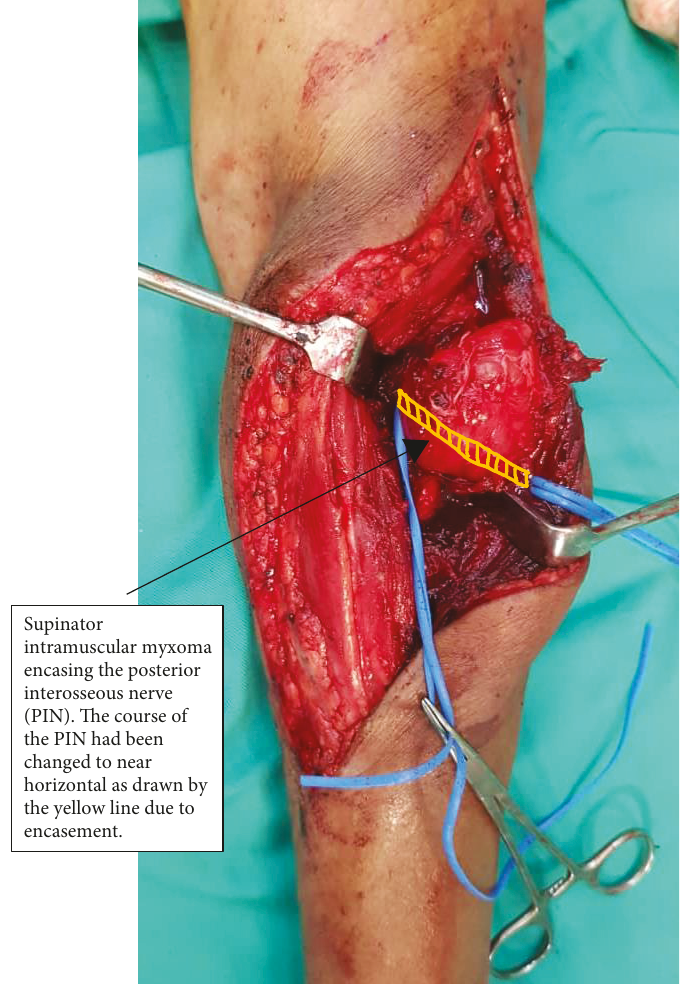
Figure 2: Intraoperative photograph showed the left supinator intramuscular myxoma encasing the posterior interosseous nerve (PIN). The course of the PIN had been changed to near horizontal as drawn by the yellow line due to